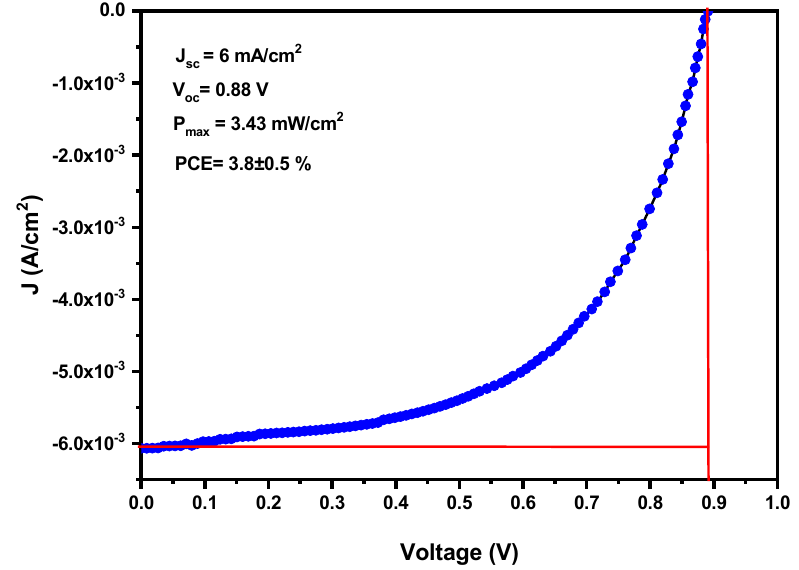
Figure 5. J-V graph of ITO/PEDOT:PSS/N749-BD/Ag device. The values of V oc , J sc and FF are measured as 0.88 V, 6.0 mA/cm 2 and 0.65, respectively. From Equation (12), PCE for the ITO/PEDOT:PSS/N749-BD/Ag device is calculated to be 3.8% ± 0.5%.